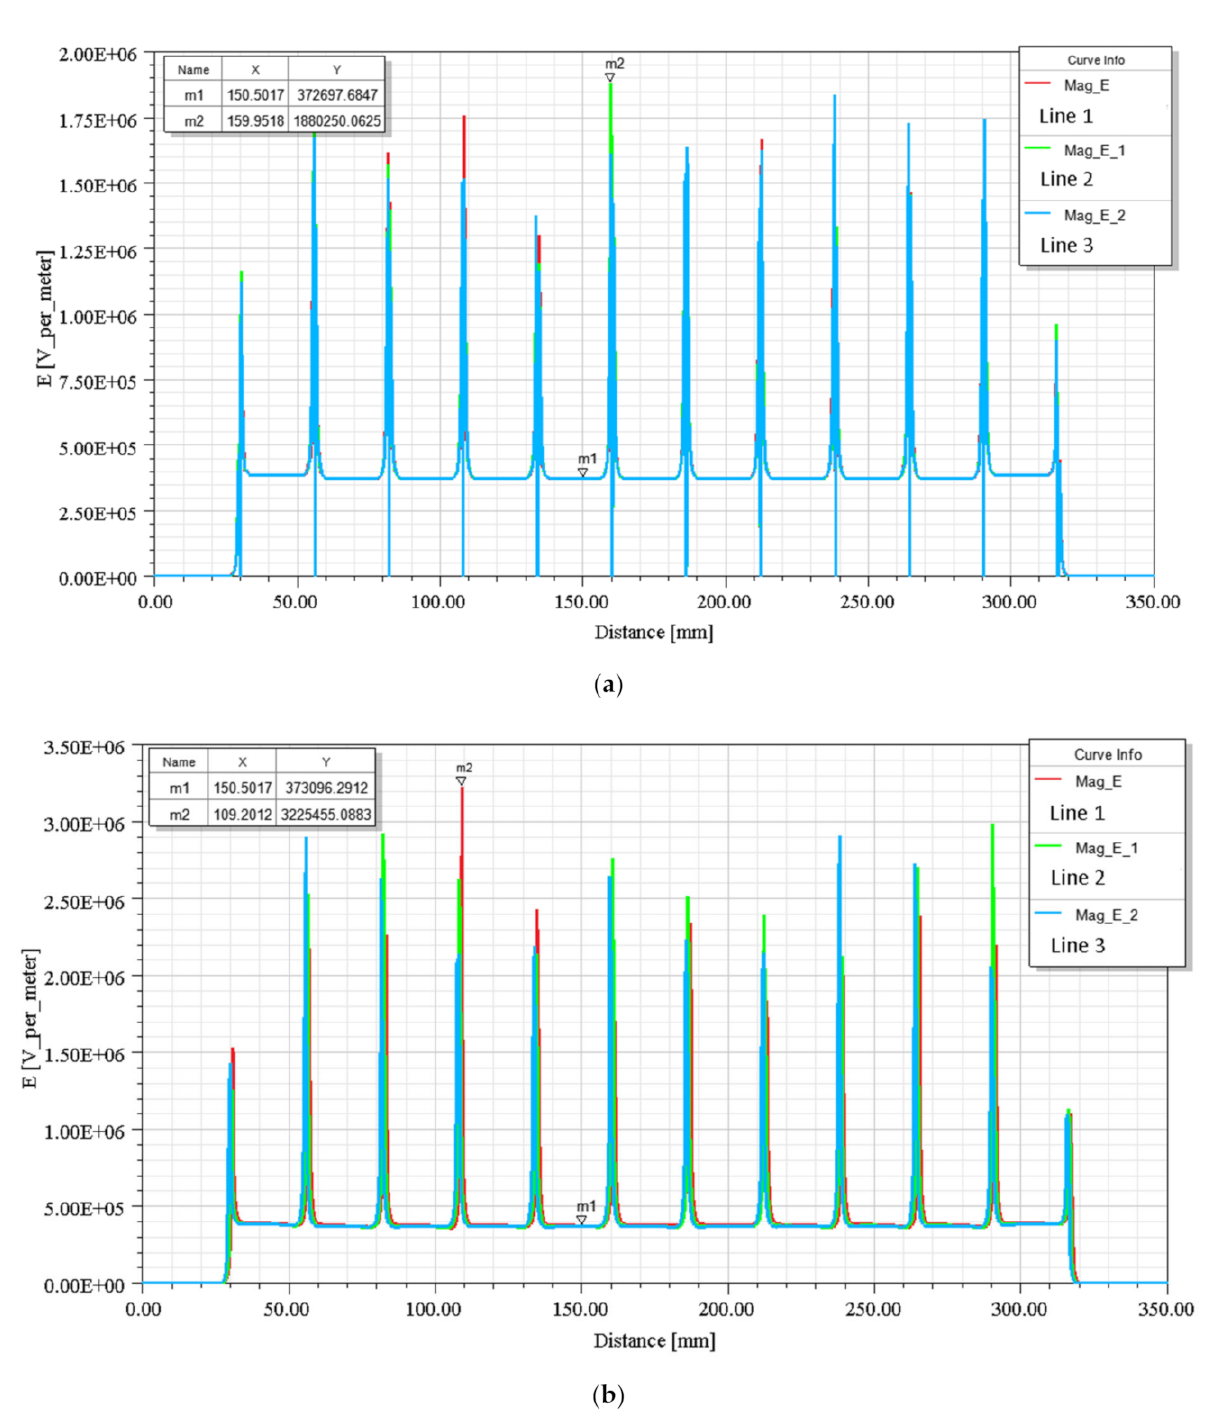
Figure 5. Electric field along the main axis of the panel: ( a ) model M1; ( b ) model